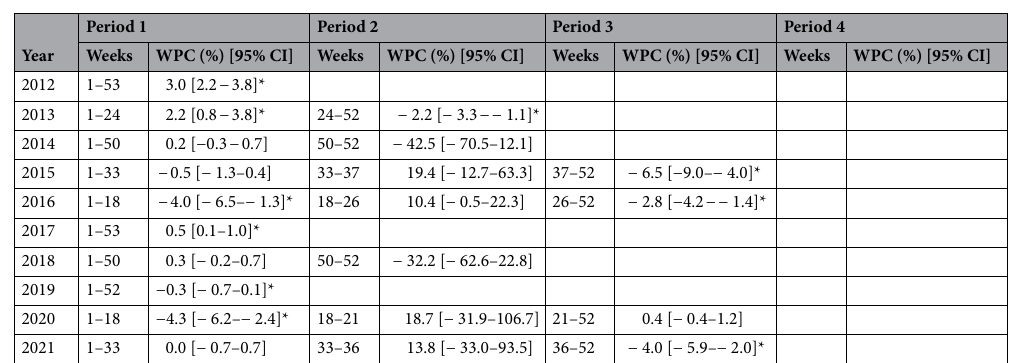
Table 3. Weekly percentage changes (WPC) in relative search volumes (RSV) of “Shikyuu-keigan (cervical cancer)” in “Health category”, by each year, 2012–2021. SE, standard error; CI, confidence interval. *Significantly different from zero ( p <